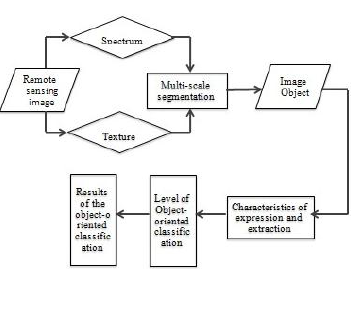
Figure. 6 Flow chart of